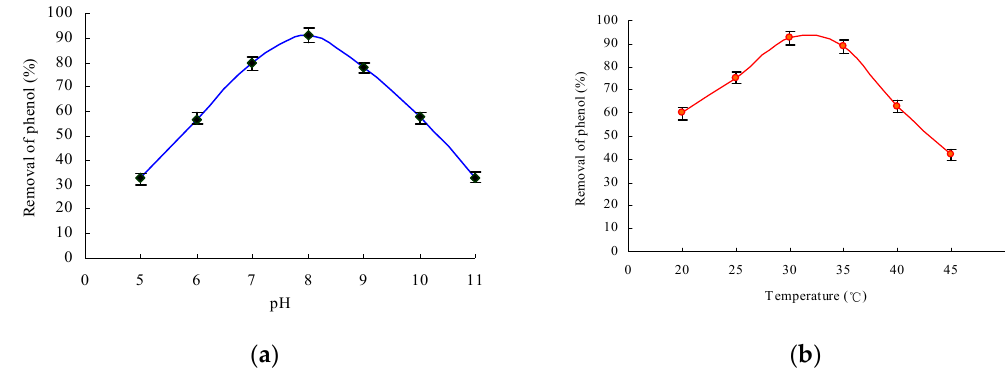
Figure 4. Effect of pH and temperature on phenol biodegradation (initial phenol concentration was 800 mg ∙ L − 1 ). ( a ) Effect of pH on the removal of phenol; ( b ) effect of temperature on the removal of phenol.